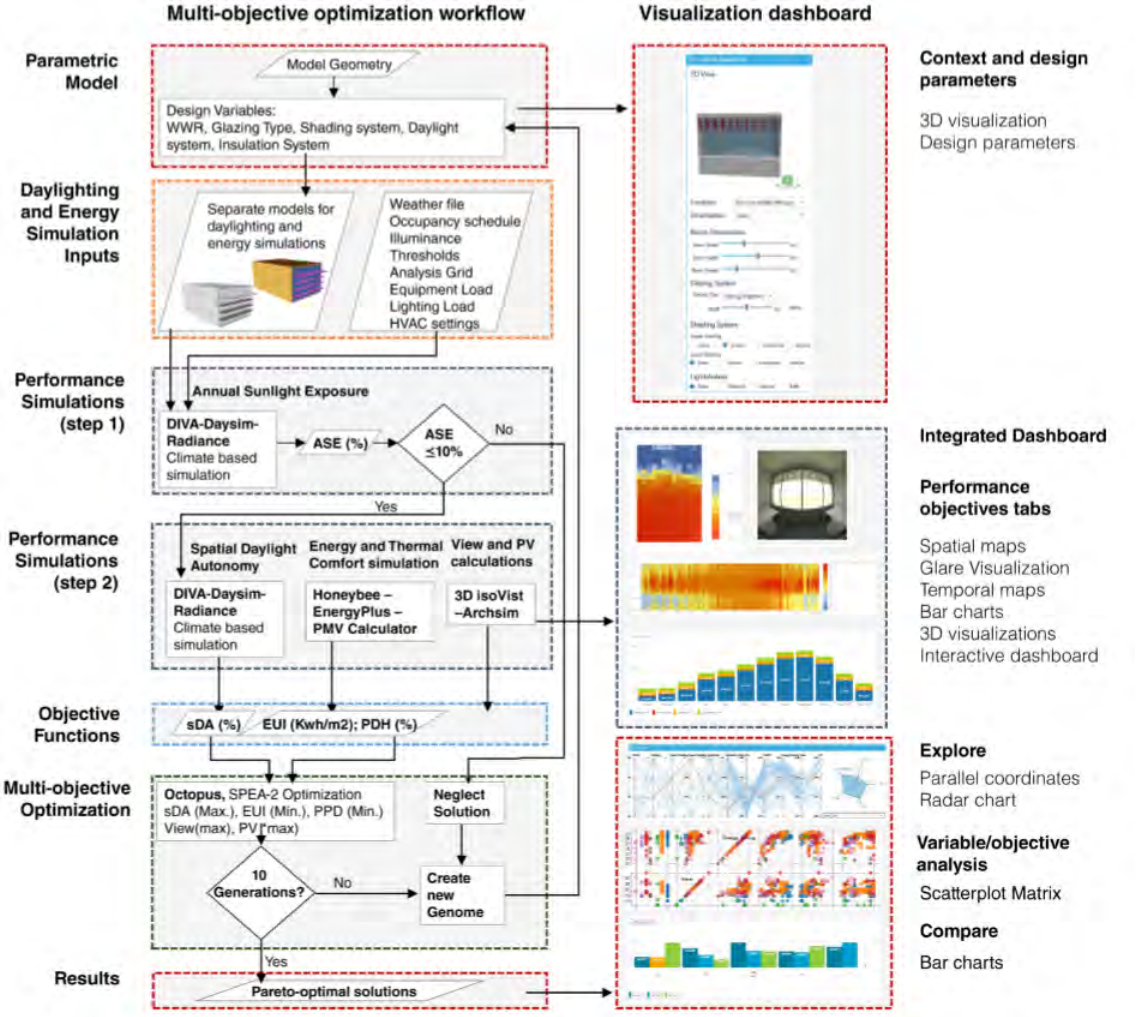
Figure 7. Optimization process workflow and the corresponding visualizations panels in some of the visualization tool (source: Gadelhak, Lang & Petzold,